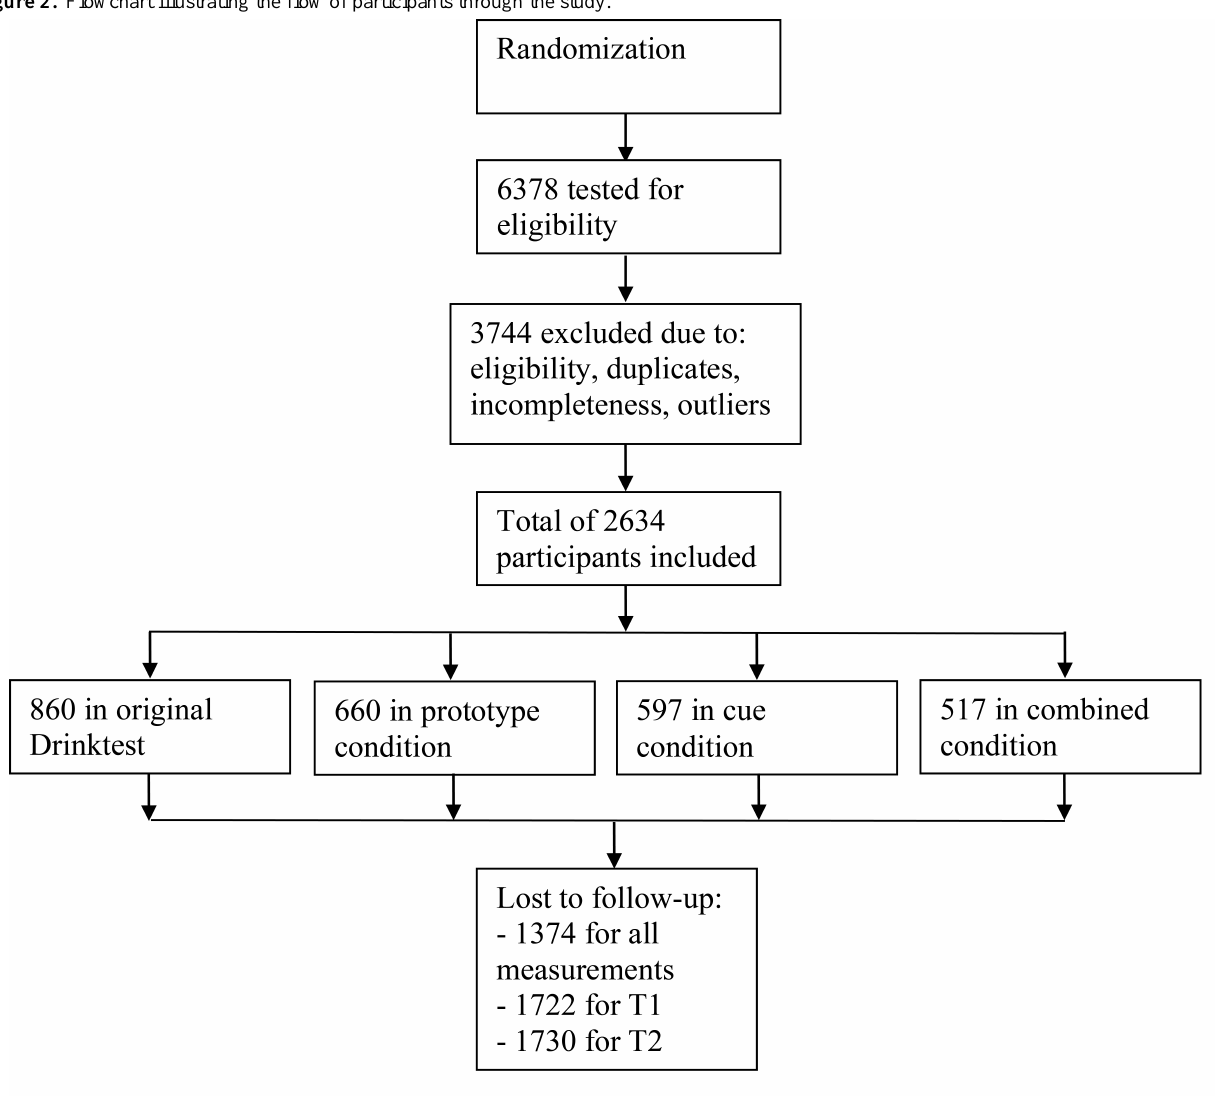
Figure 2. Flowchart illustrating the flow of participants through the